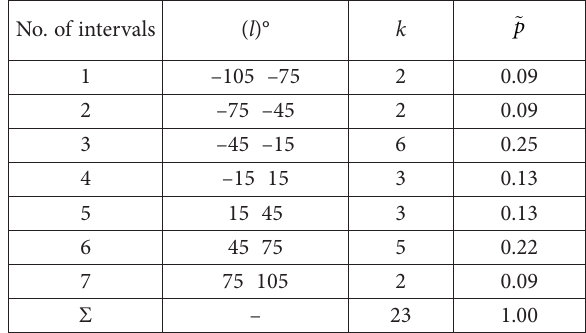
Table 4. Statistical table of distribution of deviations of directions